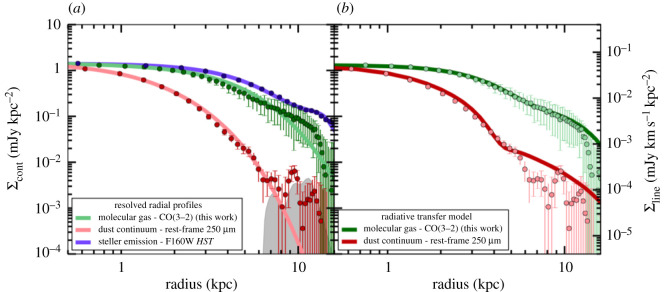
Stacked radial profiles for the cool molecular gas (traced by ALMA CO(3–2) emission), dust continuum (traced by rest-frame approx. 250 μm ALMA emission) and stellar emission (traced by H160-band HST emission) in SMGs [440]. (a) One-component exponential fits convolved with the respective beam sizes, and demonstrating that the cool molecular gas and stellar emission are clearly more extended than the rest-frame 250 μm dust continuum. (b) Best-fit model from joint radiative transfer modelling to the dust and CO emission, demonstrating that the observed size difference can be explained through radially decreasing temperature and column density distributions. Figure from Calistro Rivera et al. [440].